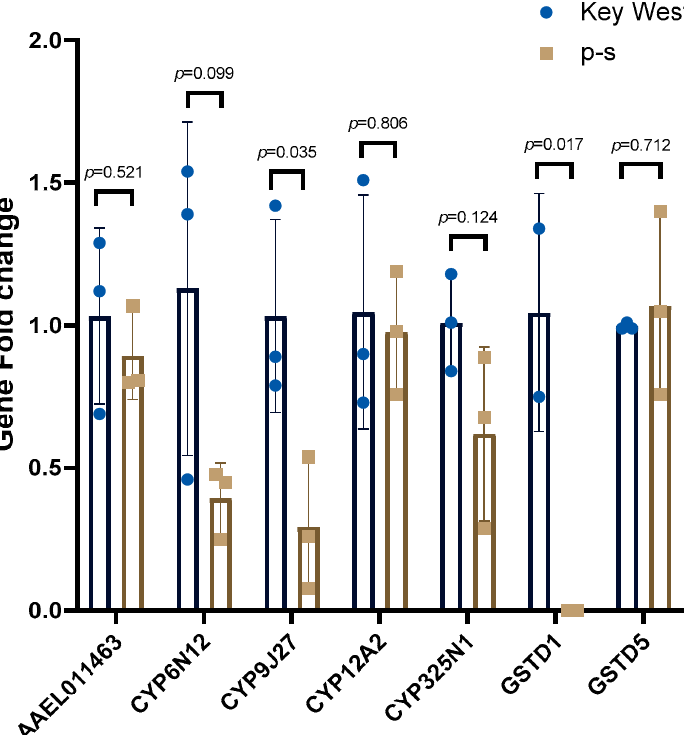
Figure 1. Relative detoxification gene expression between the p-s population and the Key West population. Three replicates of five pooled female mosquitoes were compared between p-s and Key West populations. The bar indicates the mean with standard deviation and the dots represent the expression level in each